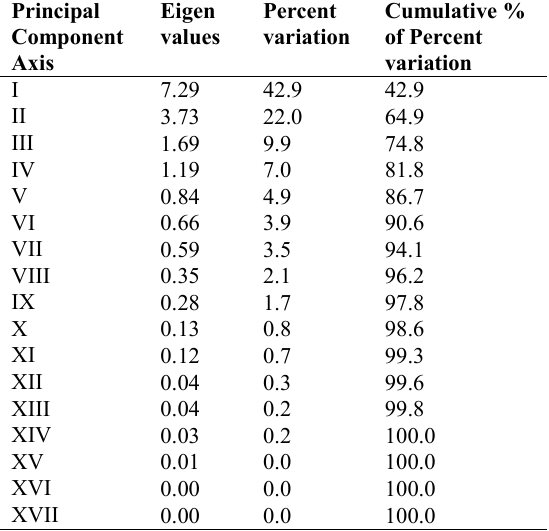
Table 4. Eigen values and yield percent